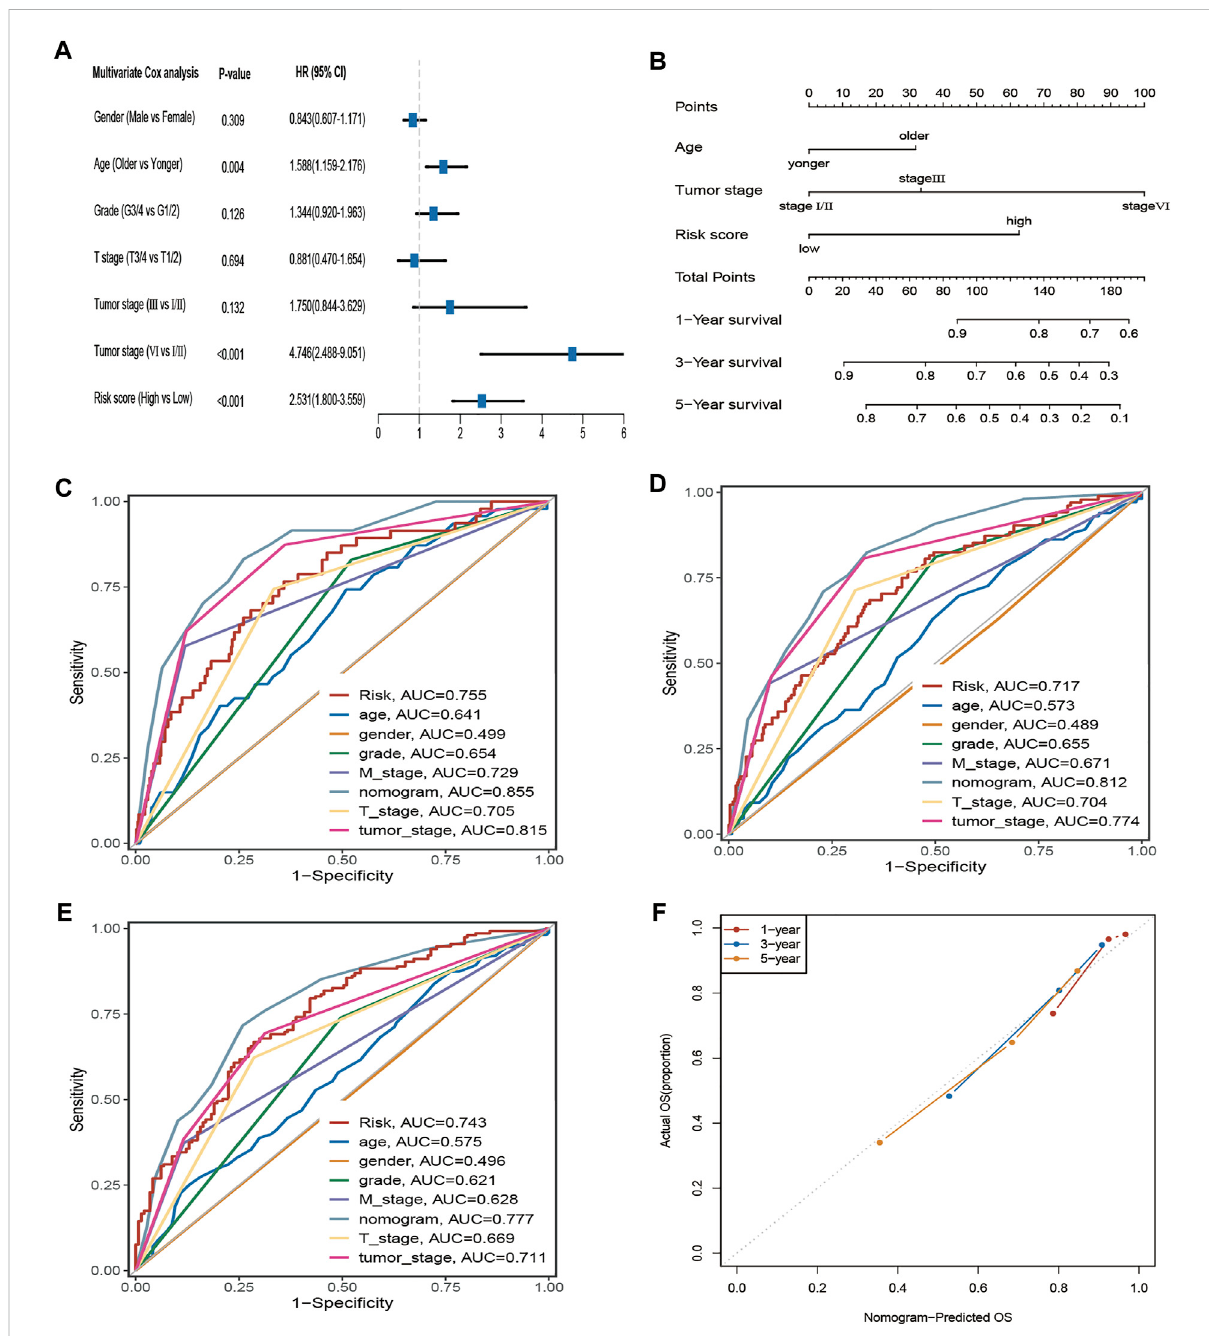
FIGURE 5 The AAM-related gene signature as an independent predictor for OS in TCGA cohorts and the predictive performance of the nomogram (risk models), risk (AAM-related gene signature), and other clinical traits. (A) The multivariate Cox regression analysis; (B) Nomogram for predicting 1-, 3-, and 5-year OS. (C – E) ROC curves for 1-year, 3-year, and 5-year OS based on the nomogram, risk, and other clinical traits, respectively; (F) the calibration plots for predicting 1-, 3-,5-year OS of the nomogram, respectively; T: AJCC TNM tumor stage; M: AJCC TNM node stage; G: WHO grade classi fi cation; tumor stage: AJCC tumor clinical